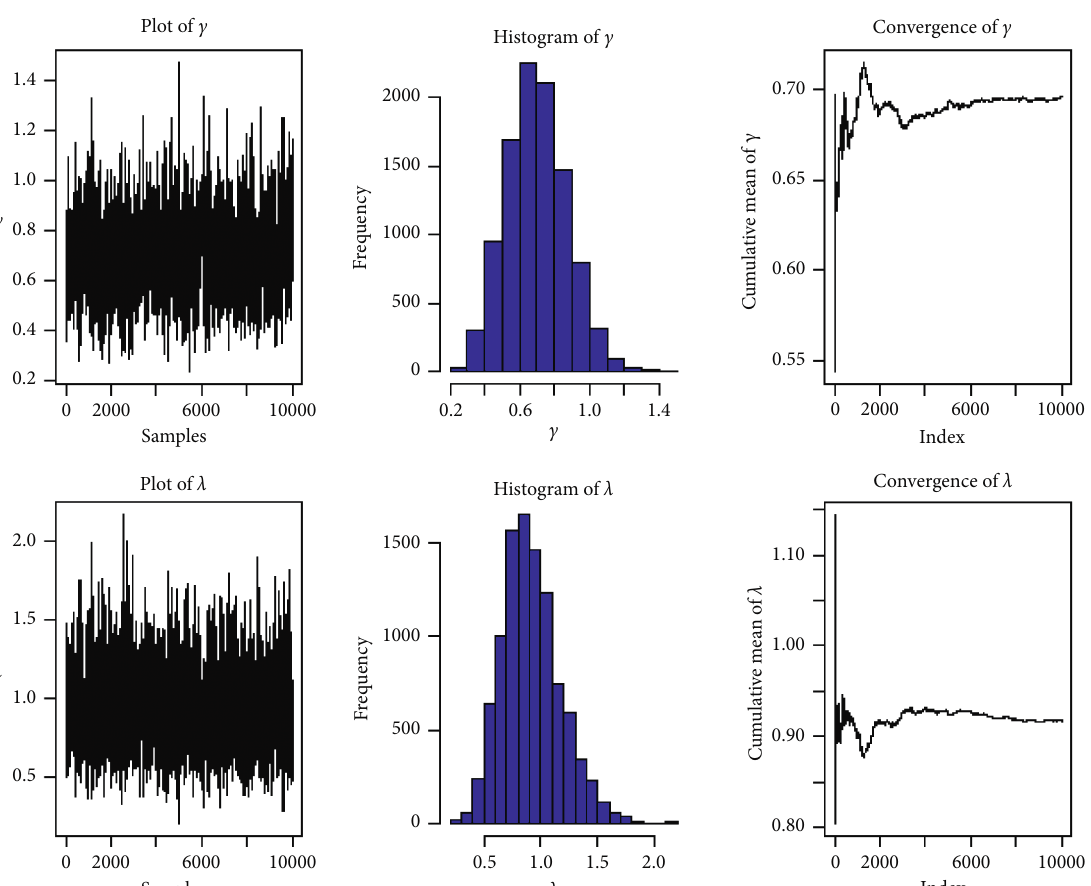
Figure 2: Convergence of MCMC estimates for c and λ implementing the MH method for data set I under PCTI m � 5 and f �